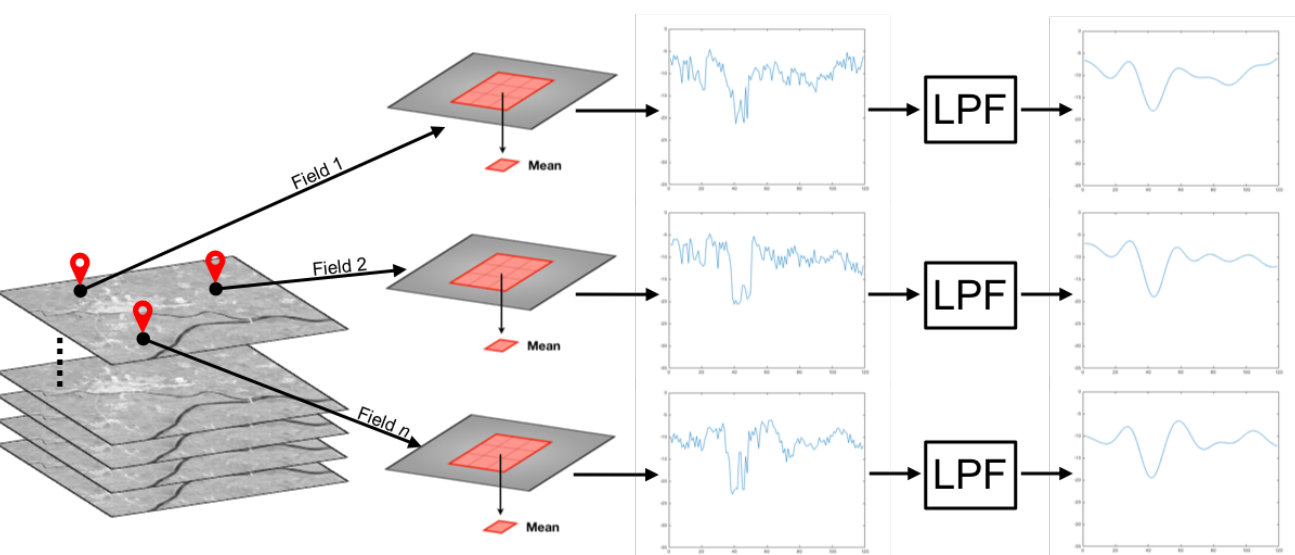
Figure 5. Mitigation of high-frequency noise. LPF stands for Low-Pass Filter.